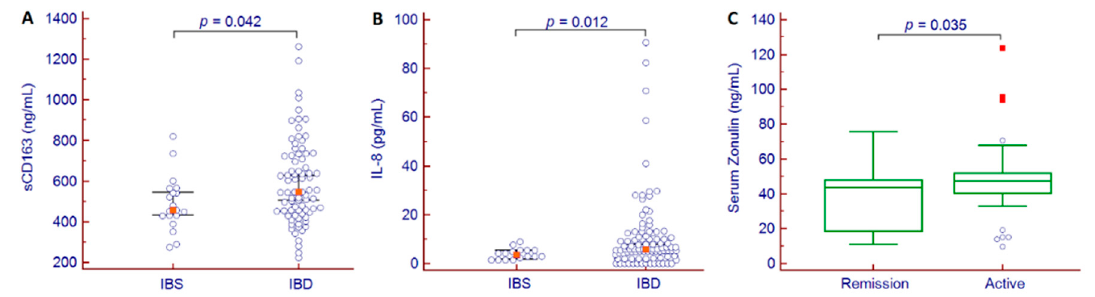
Figure 1. Comparison of sCD163 ( A ) and IL-8 ( B ) values between patients with IBS and those with IBD and serum zonulin ( C ) between IBD patients in remission and those with active disease. Abbreviations: interleukin (IL), irritable bowel syndrome (IBS), inflammatory bowel disease (IBD), soluble CD163 (sCD163).